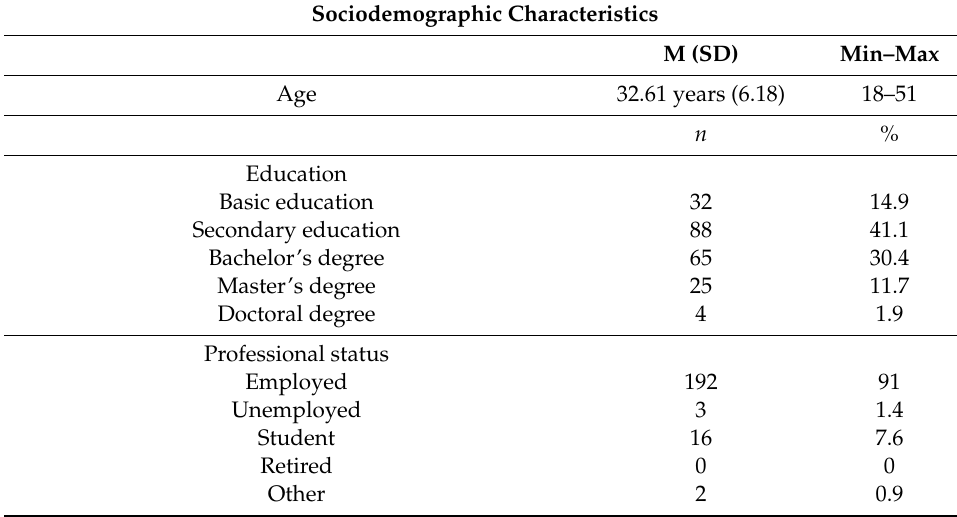
Table 1. Sociodemographic, clinical and other characteristics related to the partner ( N =